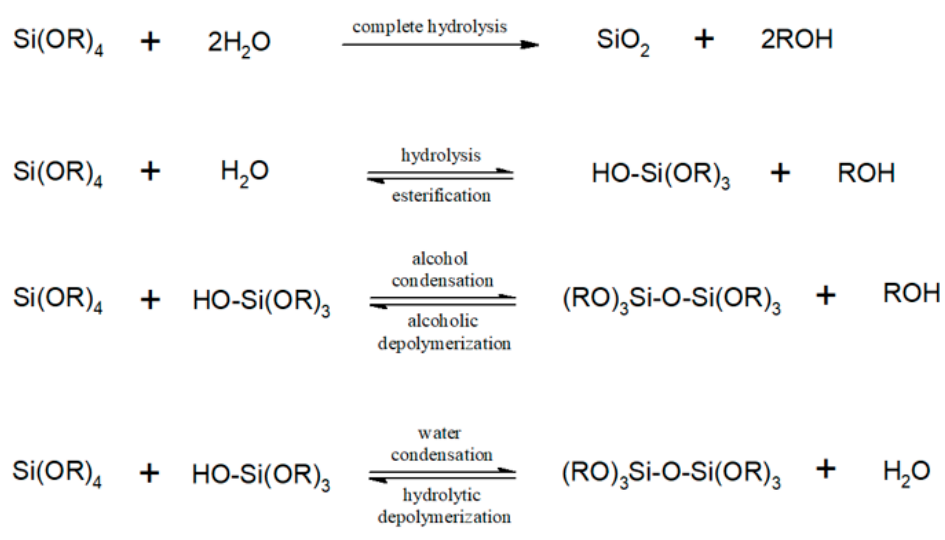
Figure 1. Hydrolysis, series of condensations and reverse reactions of silicon alkoxide.